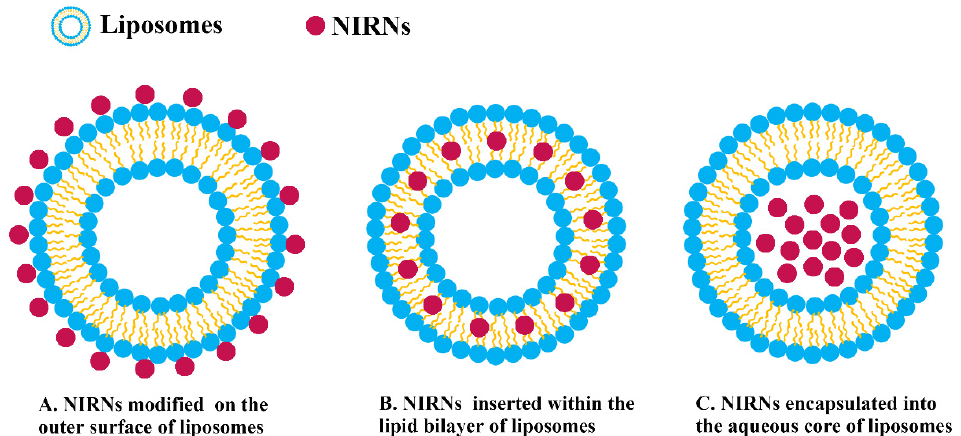
Figure 3. Three strategies developed for NIRNs attaching to liposomes.